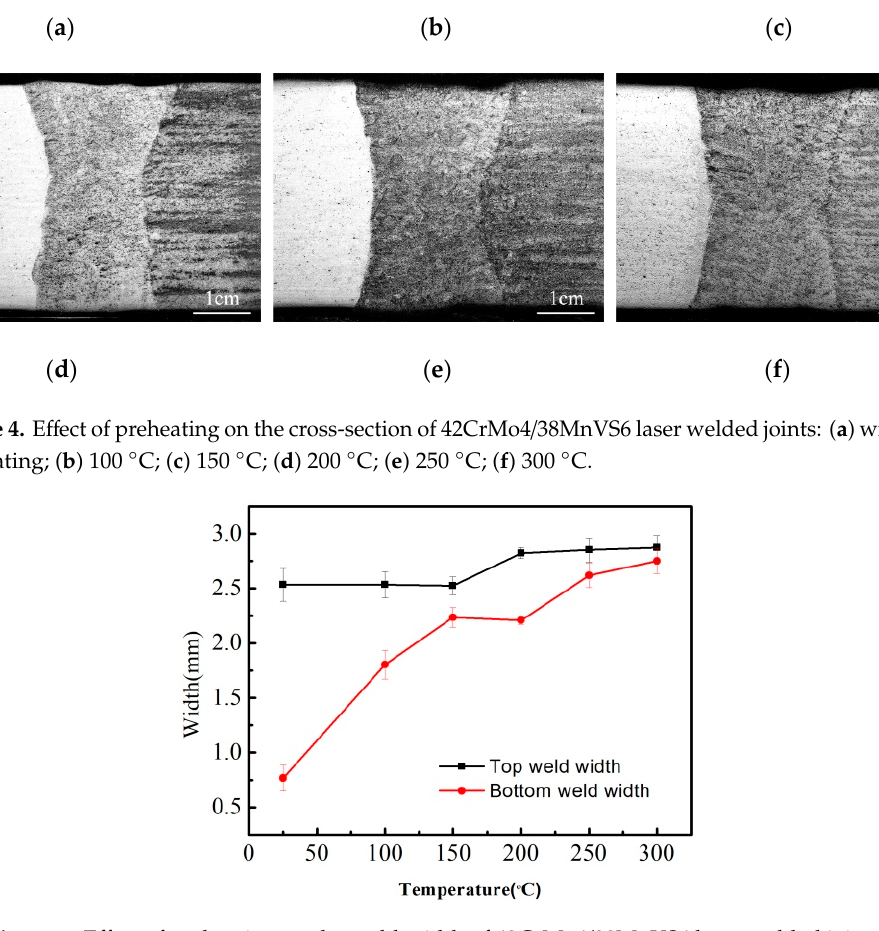
Figure 5. Effect of preheating on the weld width of 42CrMo4/38MnVS6 laser welded joints.